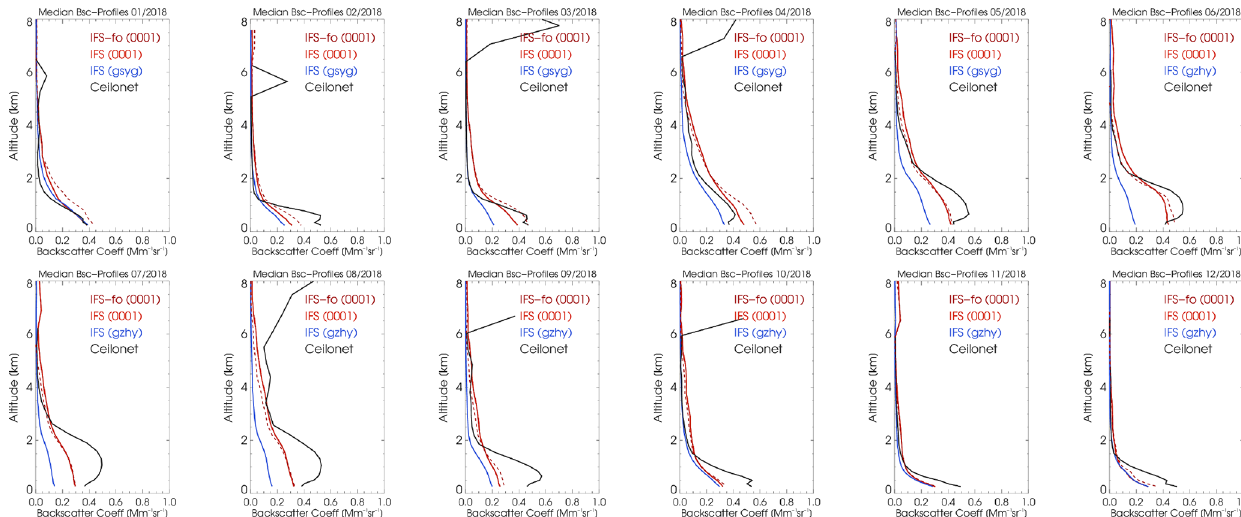
Figure D3. Monthly median profiles 2018 from the ceilometer (black), ASM (red) and control run (blue). The median profile from the IFS forward operator (available as of October 2017) is added as a dashed red line.